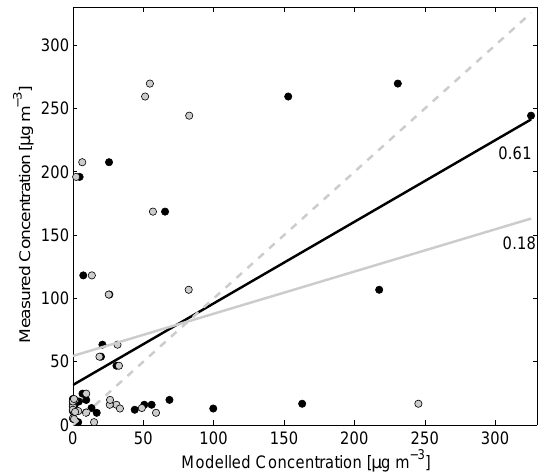
Fig. 11. Scatter plot of ash concentrations measured with the Falcon aircraft and modeled using ECMWF input data. Grey circles show a priori model results, black circles a posteriori model results. Grey and black lines show linear fits through the data and numbers are Pearson correlation coefficients, the dashed line shows the 1:1 line.